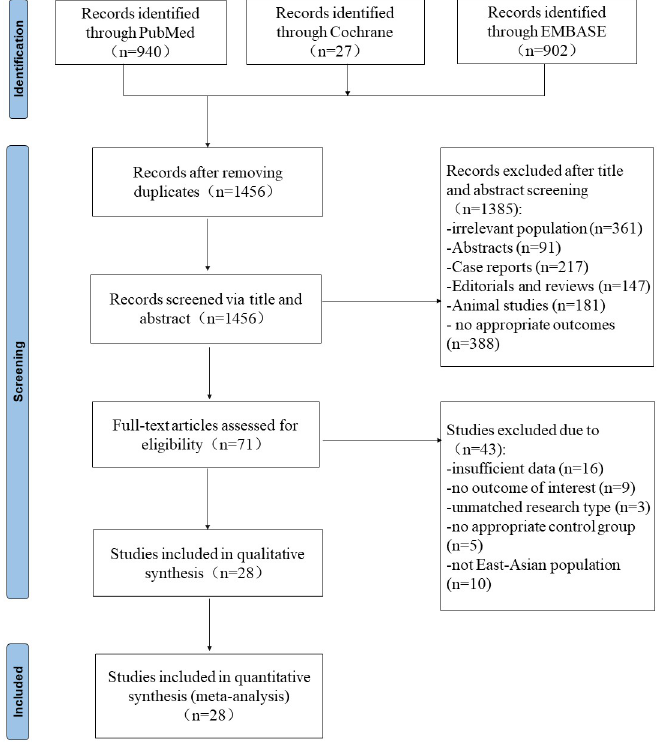
Fig 1. Screening flow chart for the systematic review and metaanalysis. It includes selecting and exclusion reasons which followed Preferred Reporting Items for Systematic Review and Metaanalysis (PRISMA) statement.